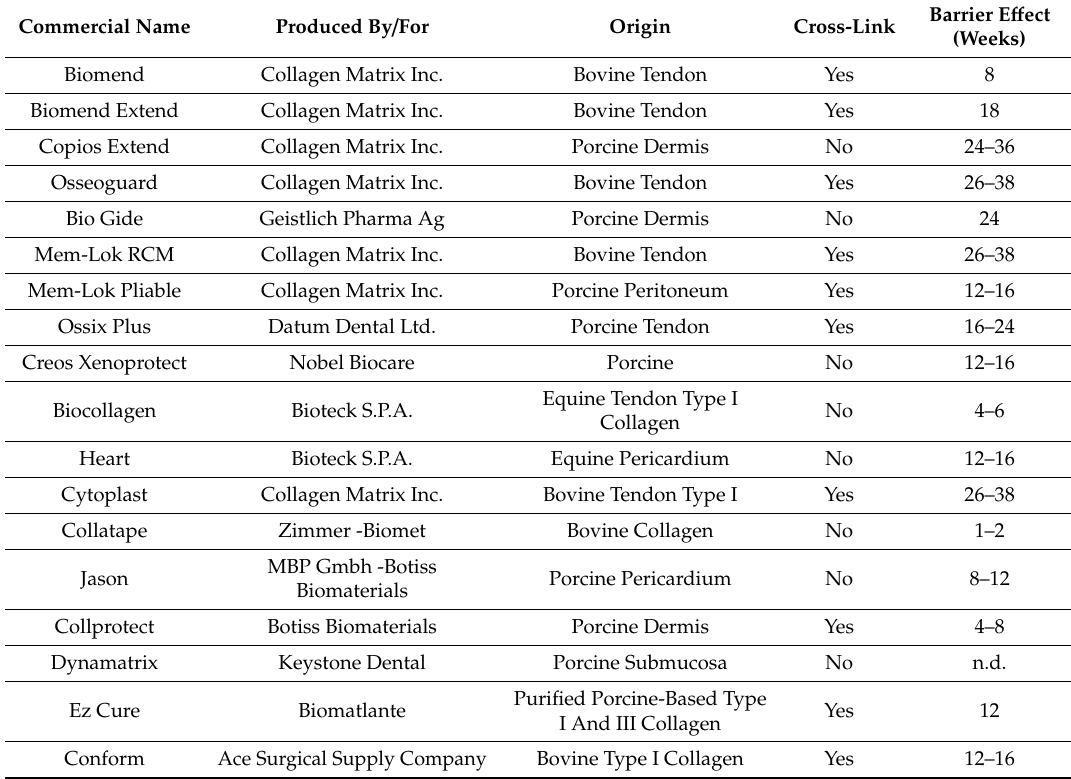
Table 2. Non-exhaustive list of available collagen membranes for clinical use (n.d. = not declared).